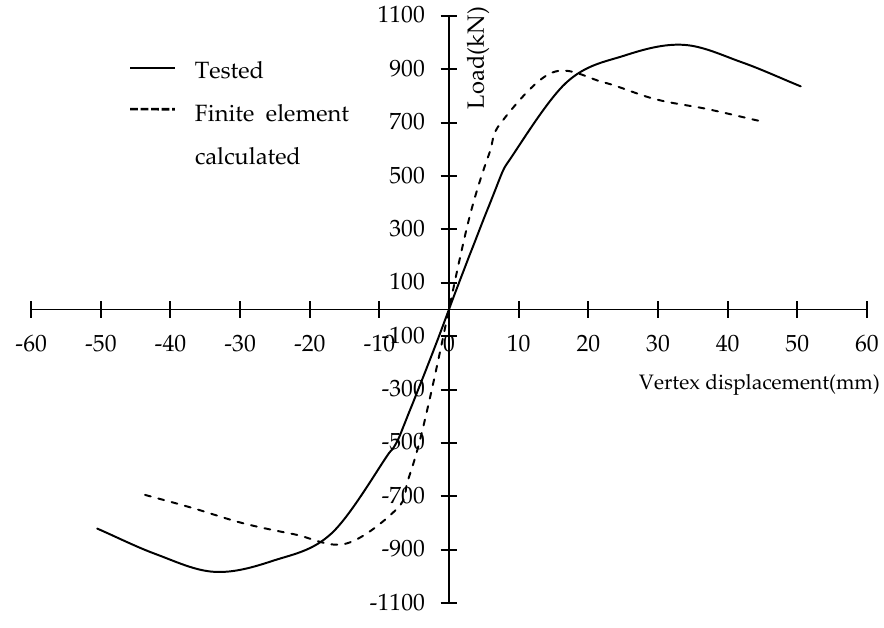
Figure 9. Load–displacement skeleton curves.